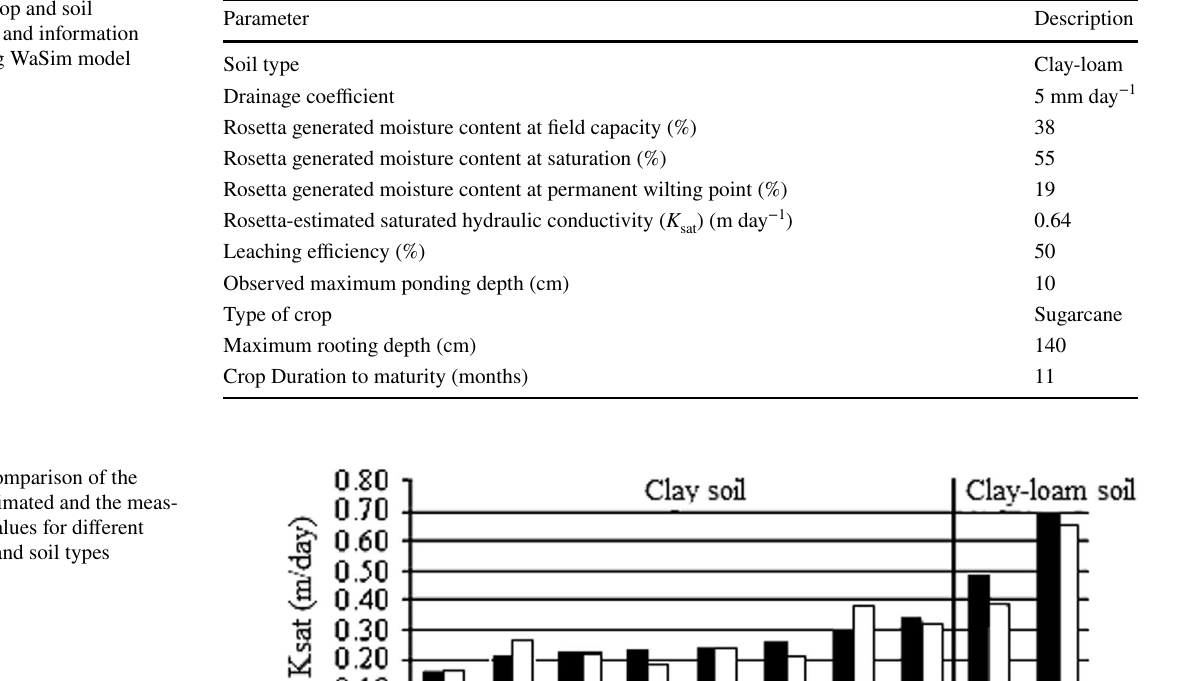
Table 1 Crop and soil parameters and information used during WaSim model calibration